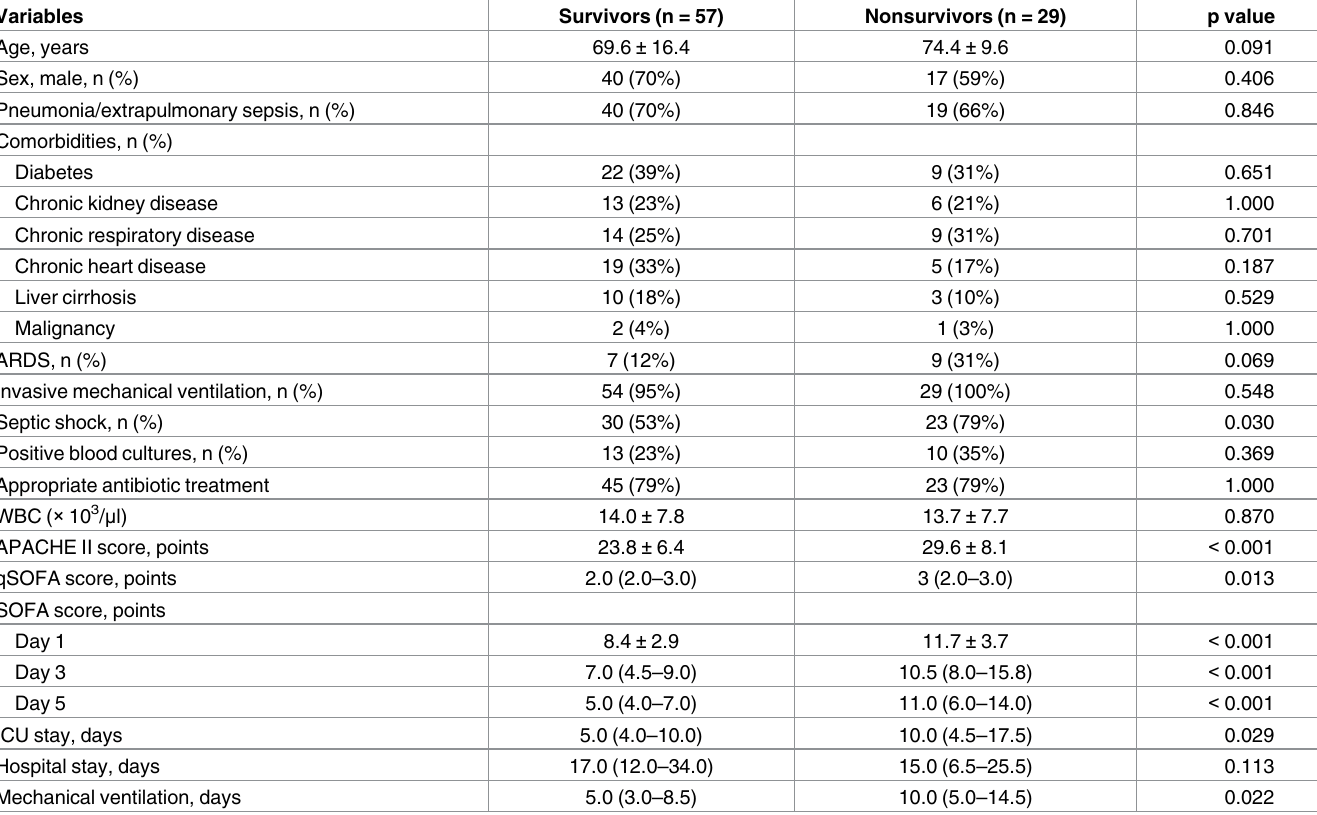
Table 1. Comparisons of characteristics between survivorsand nonsurvivors of severesepsis and septic shock.